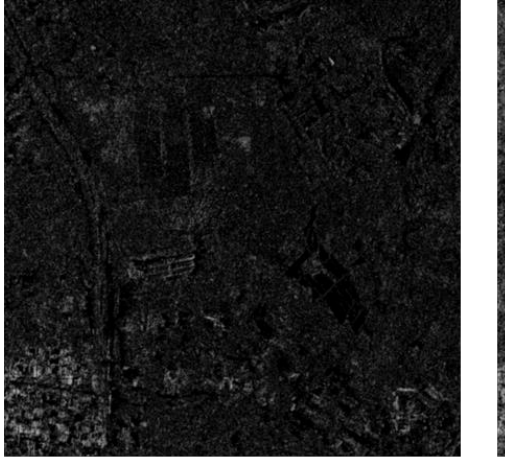
Figure 11. Complete colorization fusion results of scene 1: ( a ) Band difference map: ( b ) polarization difference map; ( c ) PCA fusion; ( d ) wavelet fusion; ( e ) NSCT fusion; ( f ) NSST fusion; and ( g ) pro- posed method fusion.